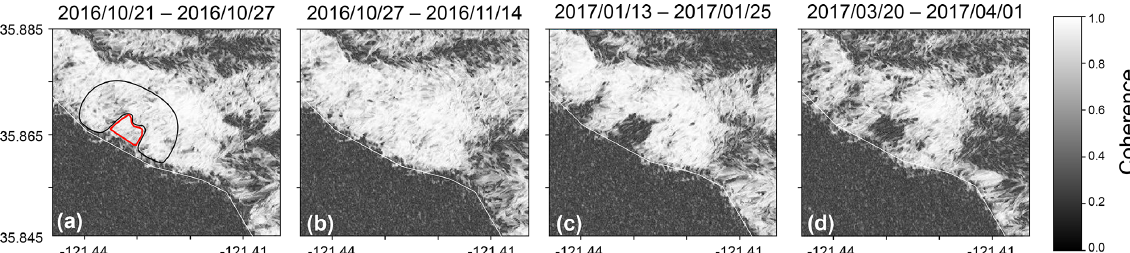
Figure 3. Interferometric coherence of the Mud Creek landslide and surrounding slope in the fall of 2016 (a, b) and spring of 2017 (c, d) . The landslide outline is marked in red, and the coherence loss in that area is clearly visible in panels (c) and (d) . The reference hillslope is outlined in black. Coherence derived from Copernicus Sentinel-1 data.